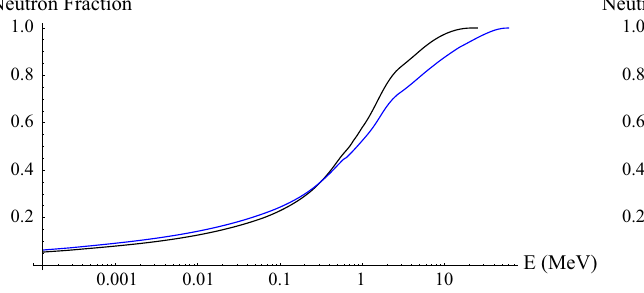
y -axis is the fraction of neutrons beneath a specific energy. On the left panel a Be target is used, while on the right panel Pb (black), W (blue) and Bi (red) targets are